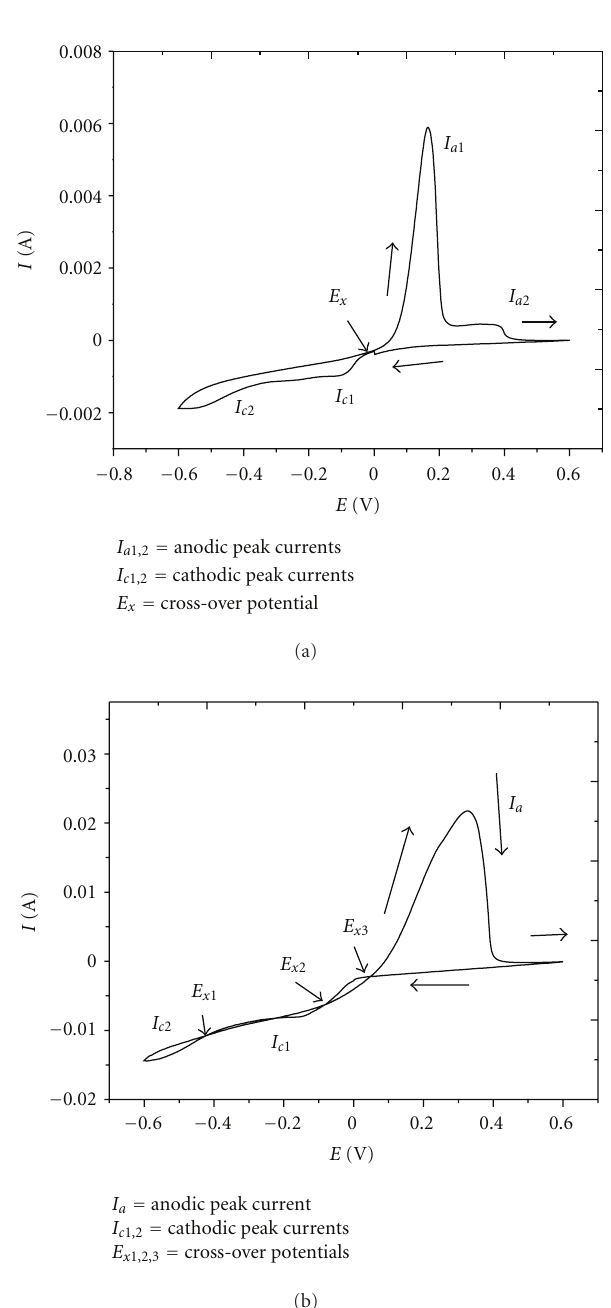
Figure 9: Cyclic voltammograms with (a) single and (b) multiple cross-over